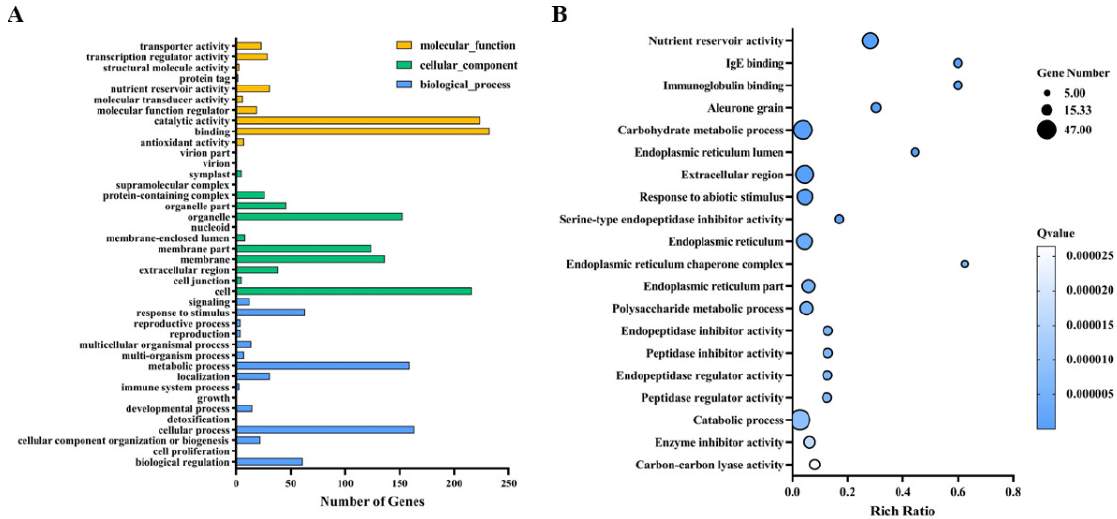
Figure 5. GO term comparison of differential genes with and without betaine soaking treatment under heat stress: ( A ) GO classification of differential genes; ( B ) bubble diagram of differential gene GO enrichment.